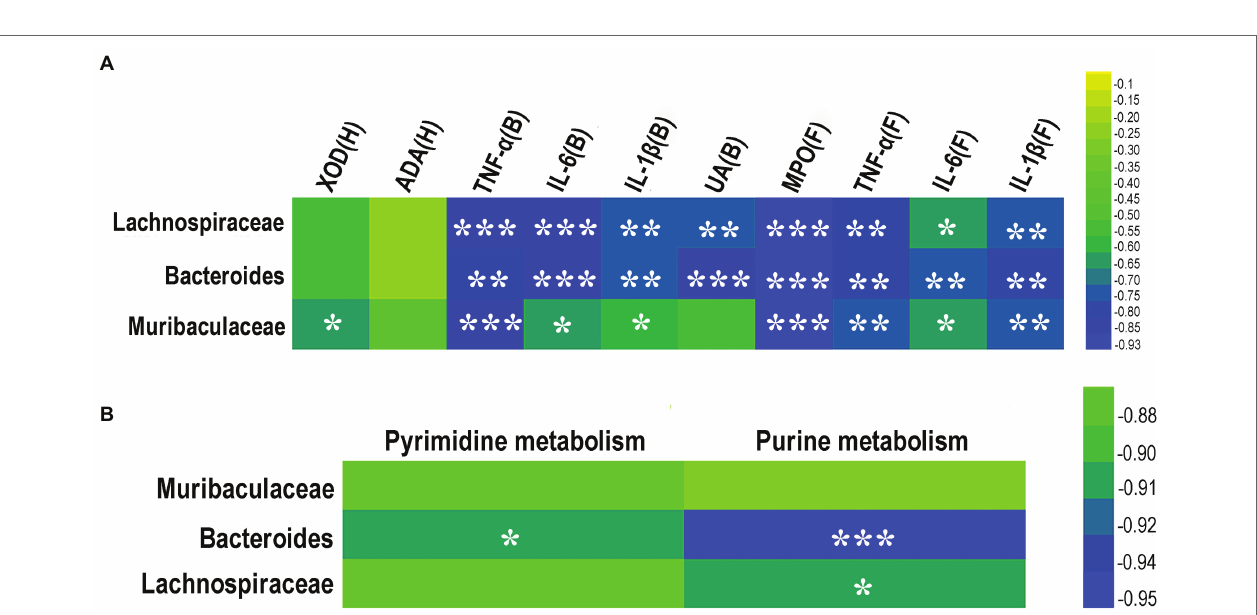
FIGURE 8 | Correlation between key gut microbes and pro-inflammatory cytokines, enzymes, and metabolic pathways from three taxa of gut microbes (i.e., Lachnospiraceae , Bacteroides , and Muribaculaceae ). (A) Correlation among pro-inflammatory cytokines and enzymes. (B) Correlation between purine and pyrimidine metabolic pathways. The color of the cell indicates the relative R values ranging from − 0.95 to 0 (i.e., blue to green). B, blood; H, hepatic tissue; and F, foot joint tissues. * p < 0.05, ** p < 0.01, and *** p <